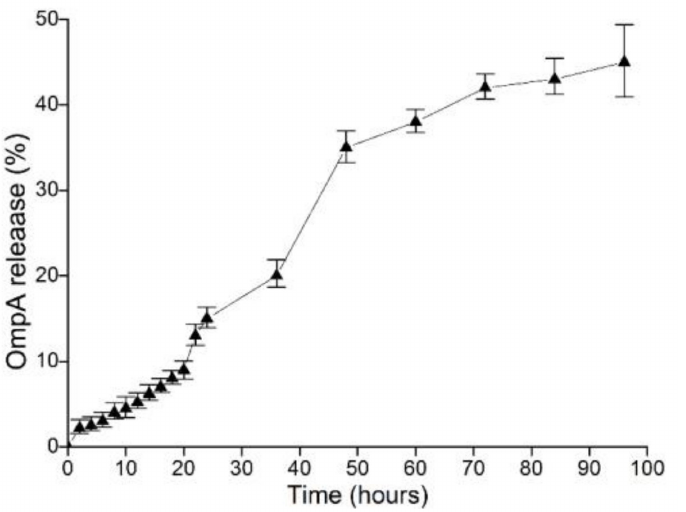
Figure 4. Characteristics of OmpA release from NP-OmpA in PBS (pH 1.2). The major release occurred from 0 to 48 h, and the release rate was